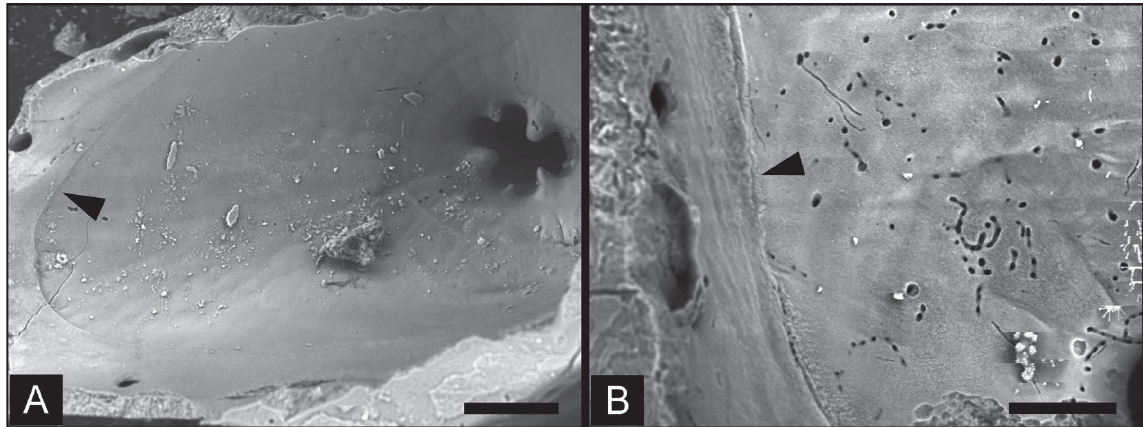
Fig. 10. interior frontal shield. A . Adeonellopsis japonica (ortmann, 1890) (NsMT-Te1052). B . A. parvi- rostrum sp. nov. (NSMT-Te807). Arrowheads indicate ring scar. SEM images. Scale bars: A = 50 μm; B = 25